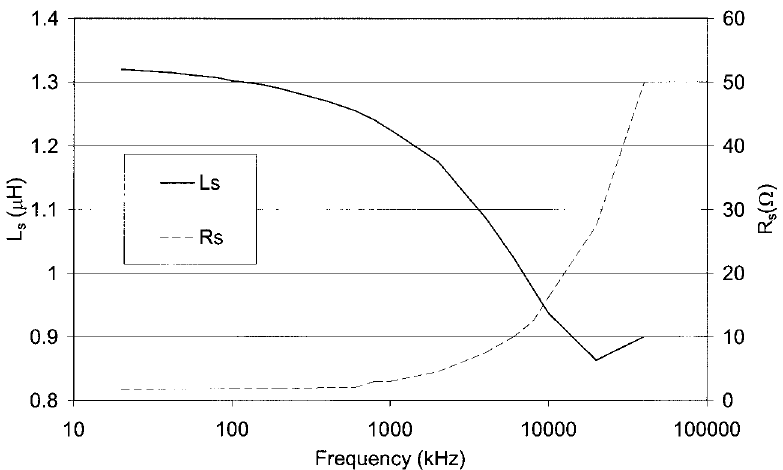
FIGURE 5 Equivalent series parameters of the multi layer sensor as a function